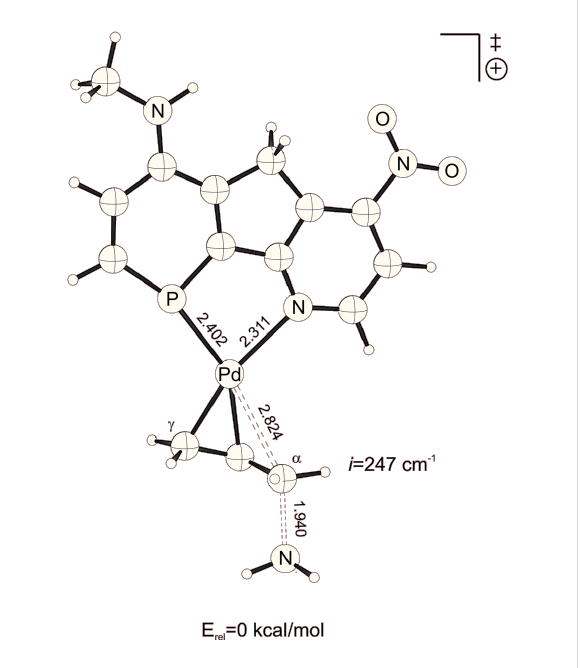
Figure 8: Transition structure for the energetically favored trans to phosphorus addition of ammonia at the Pd-η 3 -allylic intermediate (B3LYP/6-31G* (C, H, N, P, O), /SDD (Pd)). Bond distances are given in